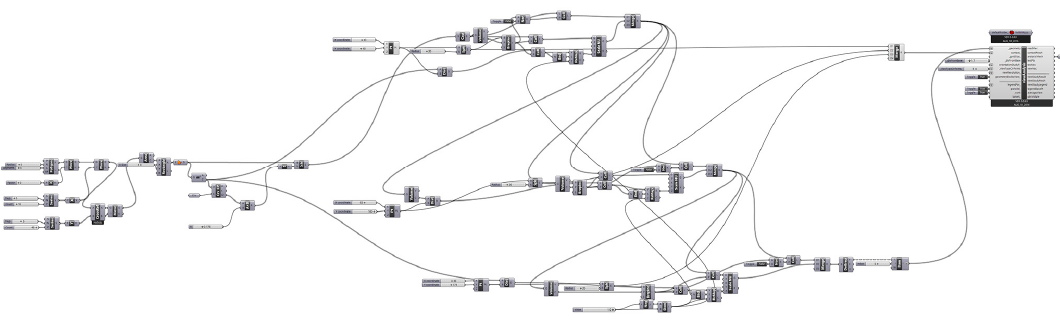
Figure 8. Perceptive analysis algorithm realized by means of plug-in Grasshopper “Lady